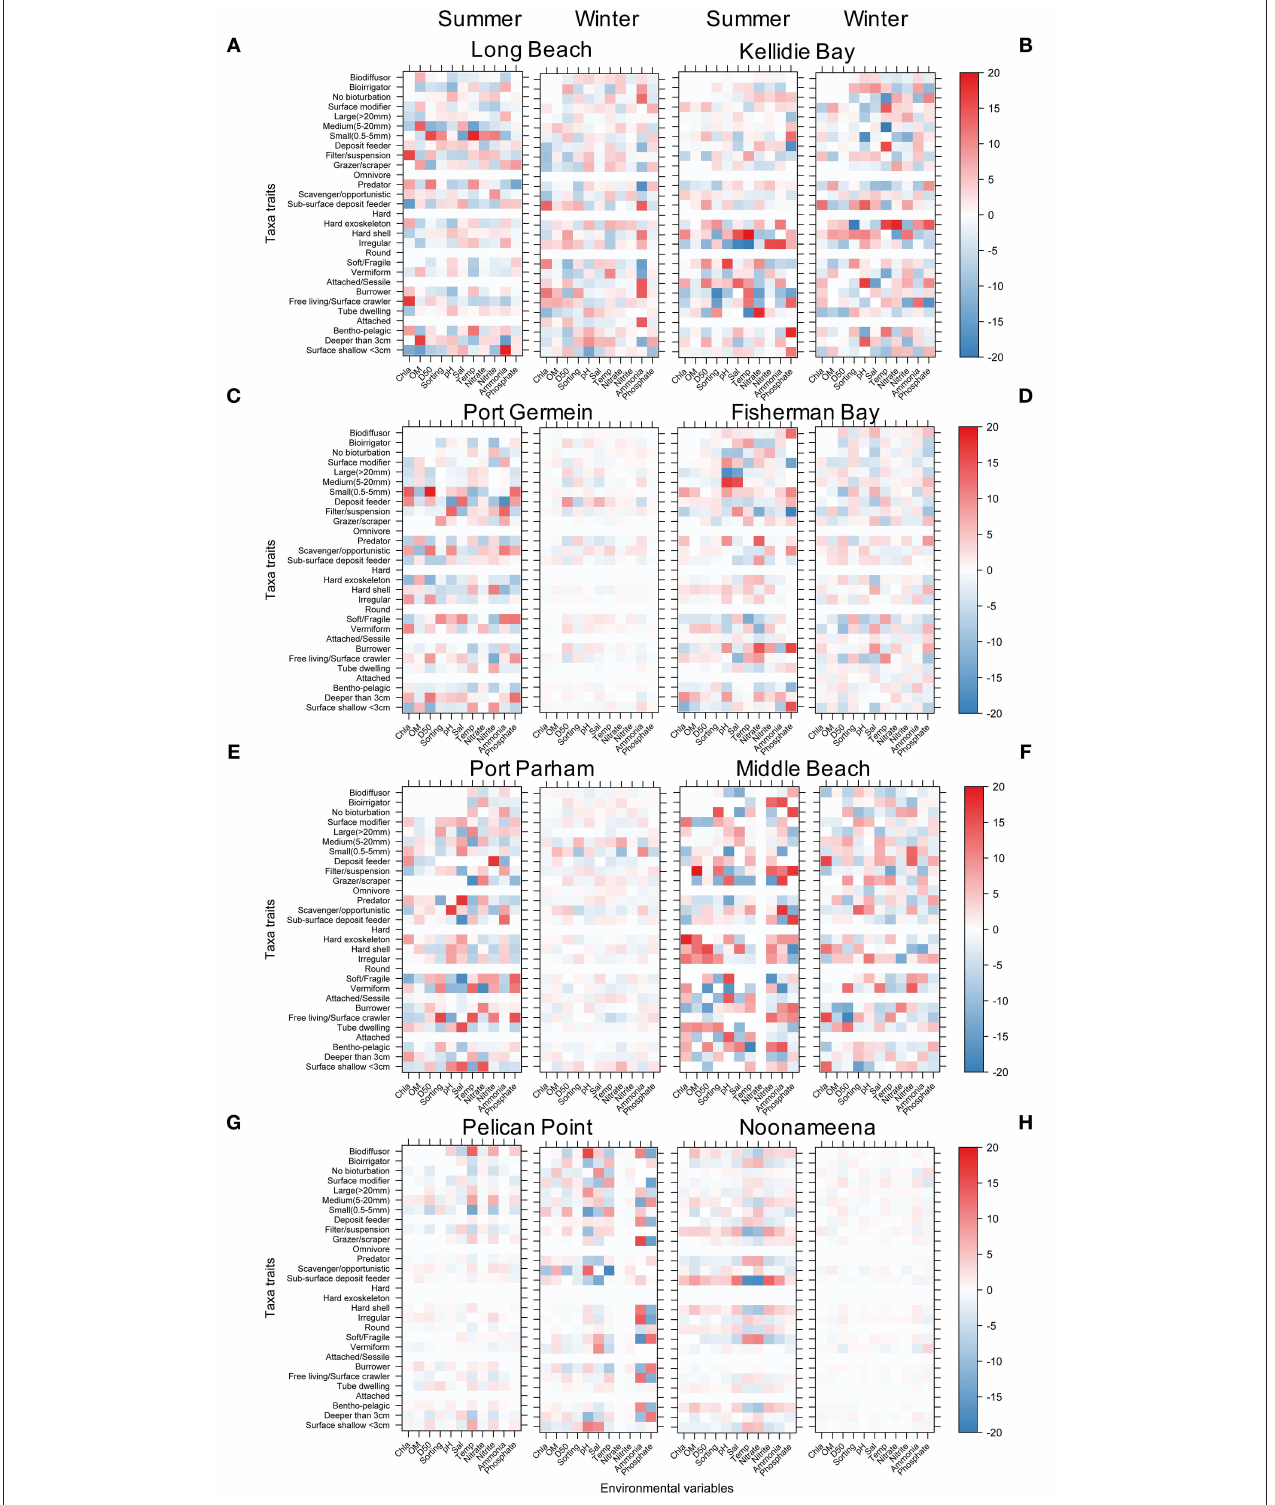
FIGURE 8 | Level plot for the fourth corner interaction (taxa abundance, traits, and environmental conditions) using NB-GLLVM showing the interactions by site and seasons. The colour scale indicates significant interactions and magnitudes of the point estimates. (A) Long Beach, (B) Kellidie Bay, (C) Port Germein, (D) Fhiserman Bay, (E) Port Parham, (F) Middle Beach, (G) Pelican Point, and (H) Noonameena.